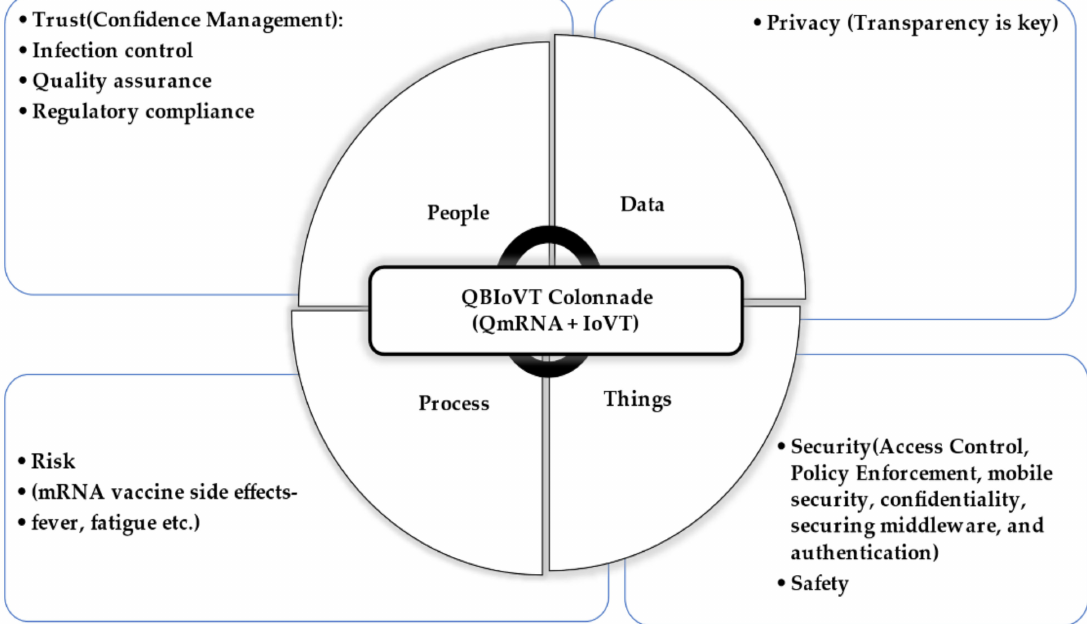
Figure 1. Quantum Biotech Internet of Virus Things (QBIoVT)QBIoVT